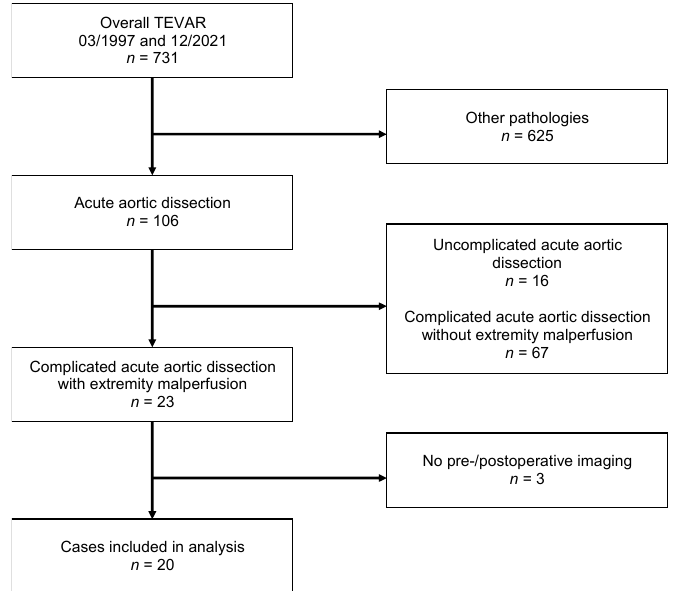
Figure 2. Flowchart of patient selection.